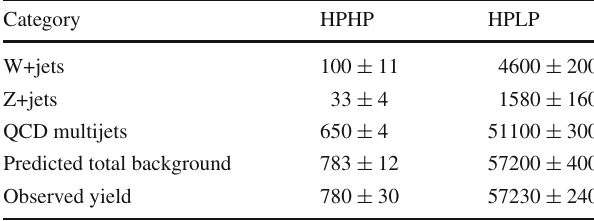
Table 3 Observed yield and background yields extracted from the